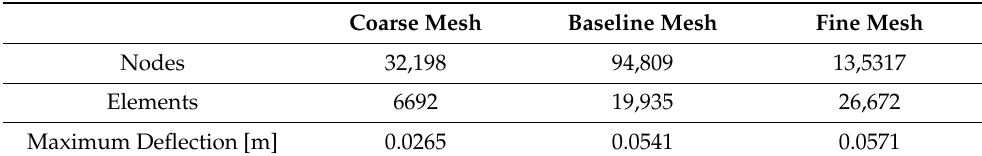
Figure 6. Finite element analysis (FEA) mesh: ( a ) blade and ( b ) close-up view of the blade tip. Table 6. Details of the different meshes used in the mesh sensitivity study.